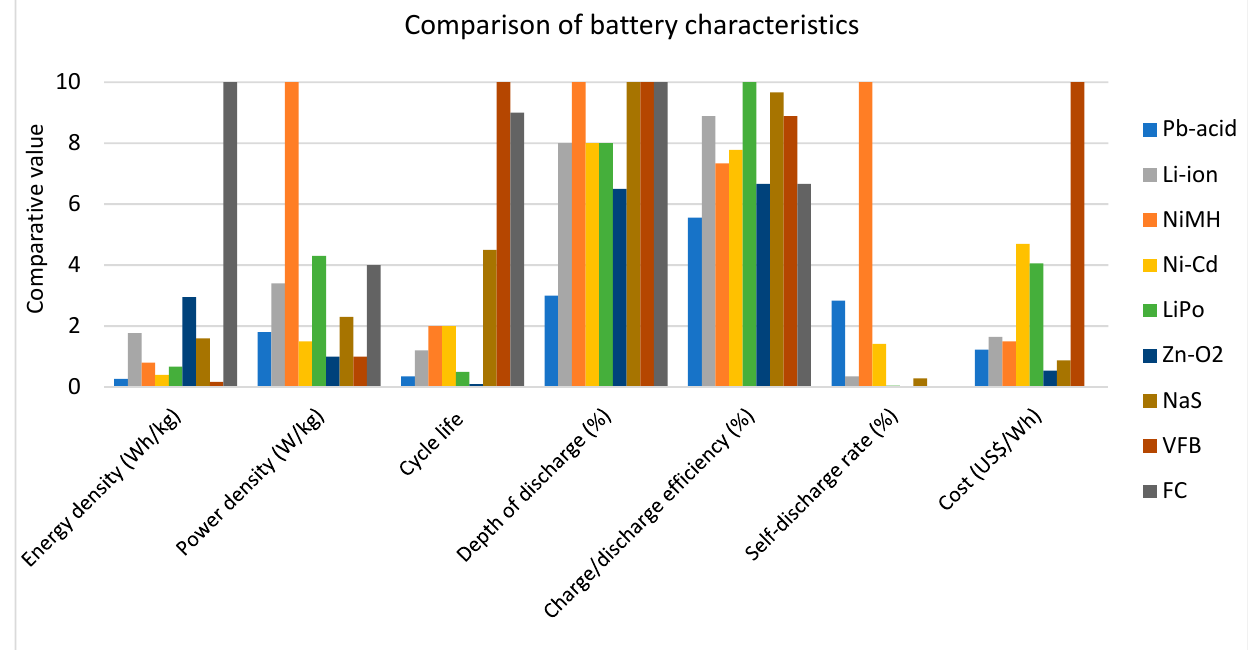
Figure 2. Comparison of different battery characteristics, adapted from [24–29].